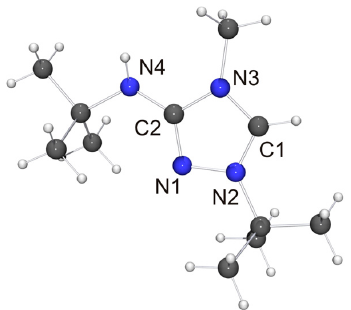
Figure 3. Molecular structure of the cation of 6 H[BF 4 ] in the crystal. Selected bond lengths [Å] and angles [°]: C1 ‒ N2 1.310(1), C1 ‒ N3 1.340(1), C2 ‒ N1 1.320(1), C2 ‒ N3 1.380(1), C2 ‒ N4 1.351(1), N1 ‒ N2 angles [ ◦ ]: C1–N2 1.310(1), C1–N3 1.340(1), C2–N1 1.320(1), C2–N3 1.380(1), C2–N4 1.351(1),